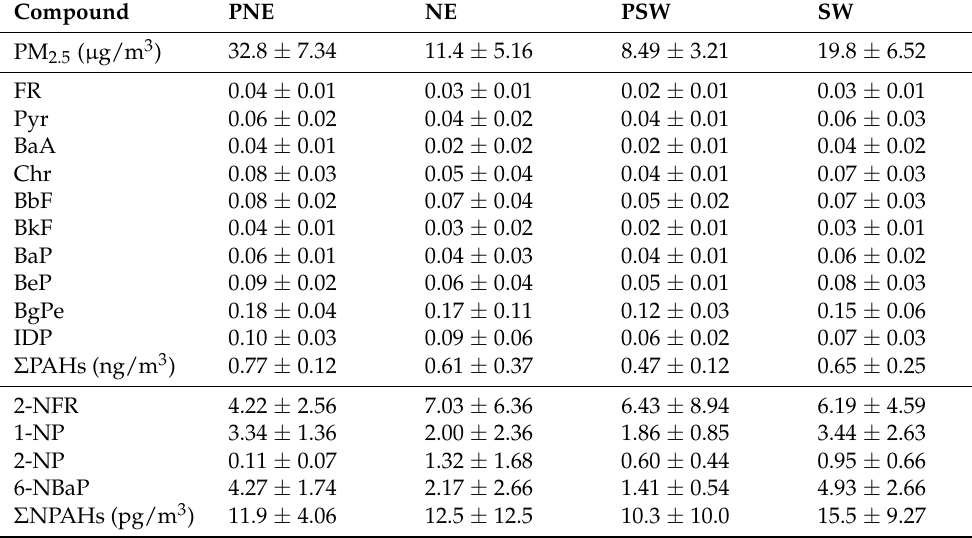
Table 1. The mean concentration and standard deviation of PM 2.5 , ten PAHs and four NPAHs in PM 2.5 in Singapore from 2020 to